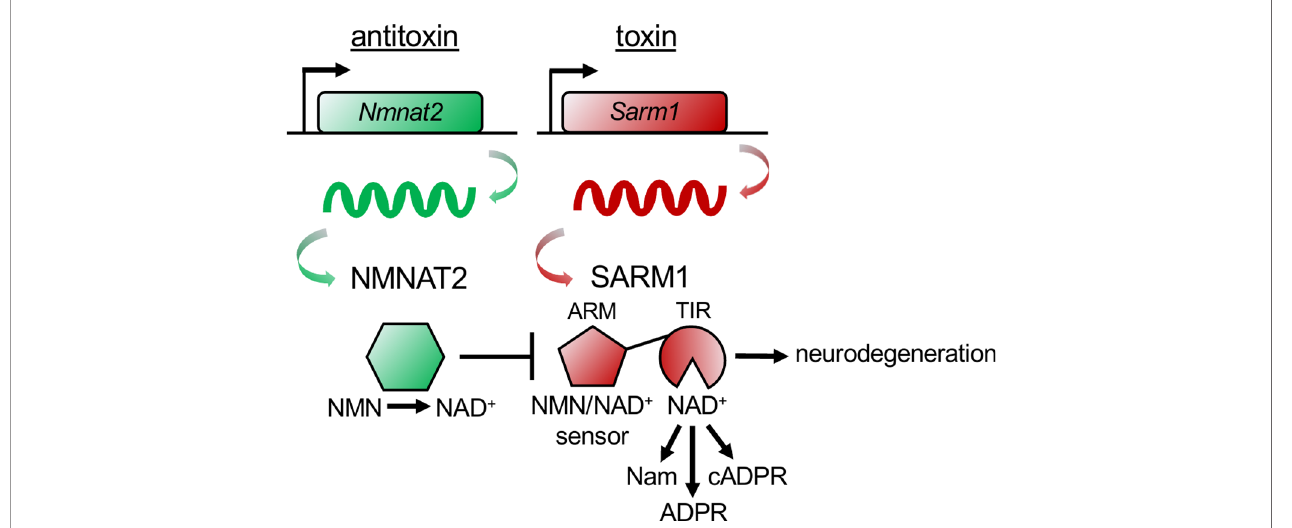
FIGURE 2 | The NMNAT2 antitoxin inhibits the SARM1 toxin to prevent axon degeneration. The antitoxin NMNAT2 converts nicotinamide mononucleotide (NMN) to nicotinamide adenine dinucleotide (NAD+) and thus maintains a healthy NMN/NAD+ ratio in axons. SARM1 ’ s ARM domain senses the ratio of NMN/NAD+ by binding to either metabolite. When the antitoxin NMNAT2 is lost, the NMN/NAD+ ratio rises, NMN binds to the toxin SARM1 ’ s ARM domain, activating SARM1 ’ s TIR domains to hydrolyze NAD+, producing nicotinamide (Nam) and adenosine diphosphate ribose (ADPR), or cyclizing ADPR into cyclic ADPR (cADPR). Activation of the toxin SARM1 drives pathological axon